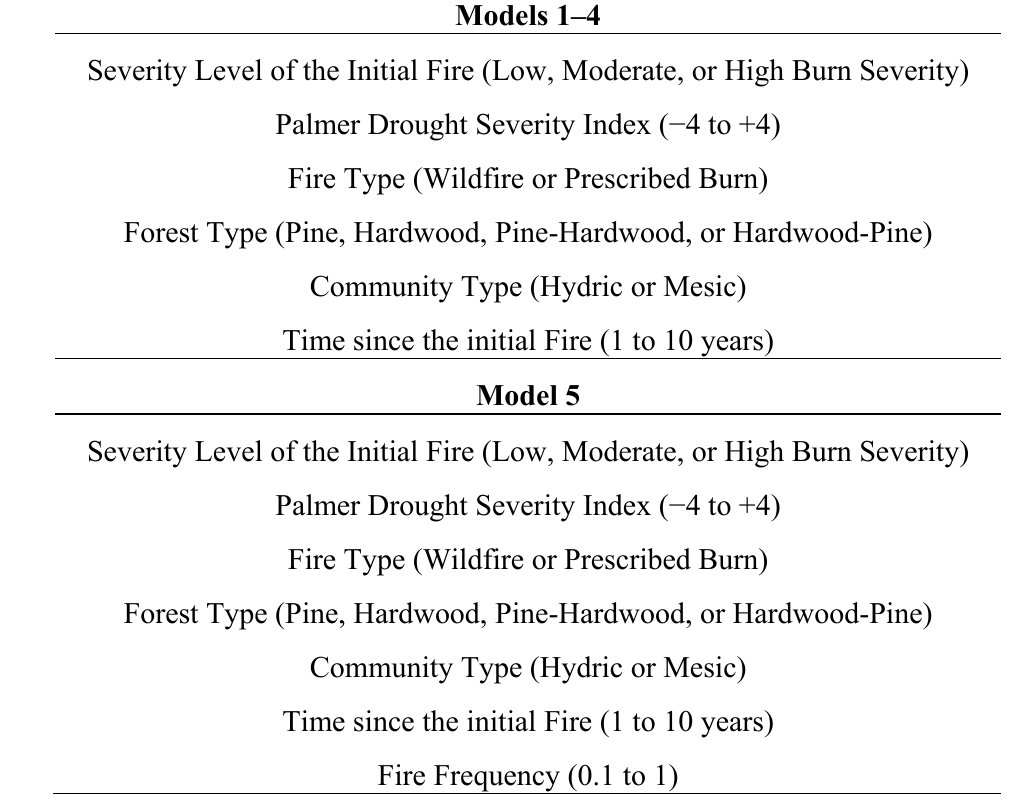
Table 2. Independent variable inputs to models of subsequent fire and severity (all first-order interactions were also